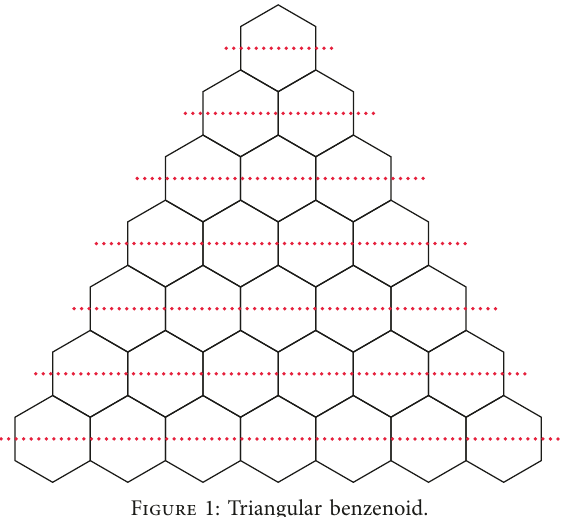
Figure 1: Triangular